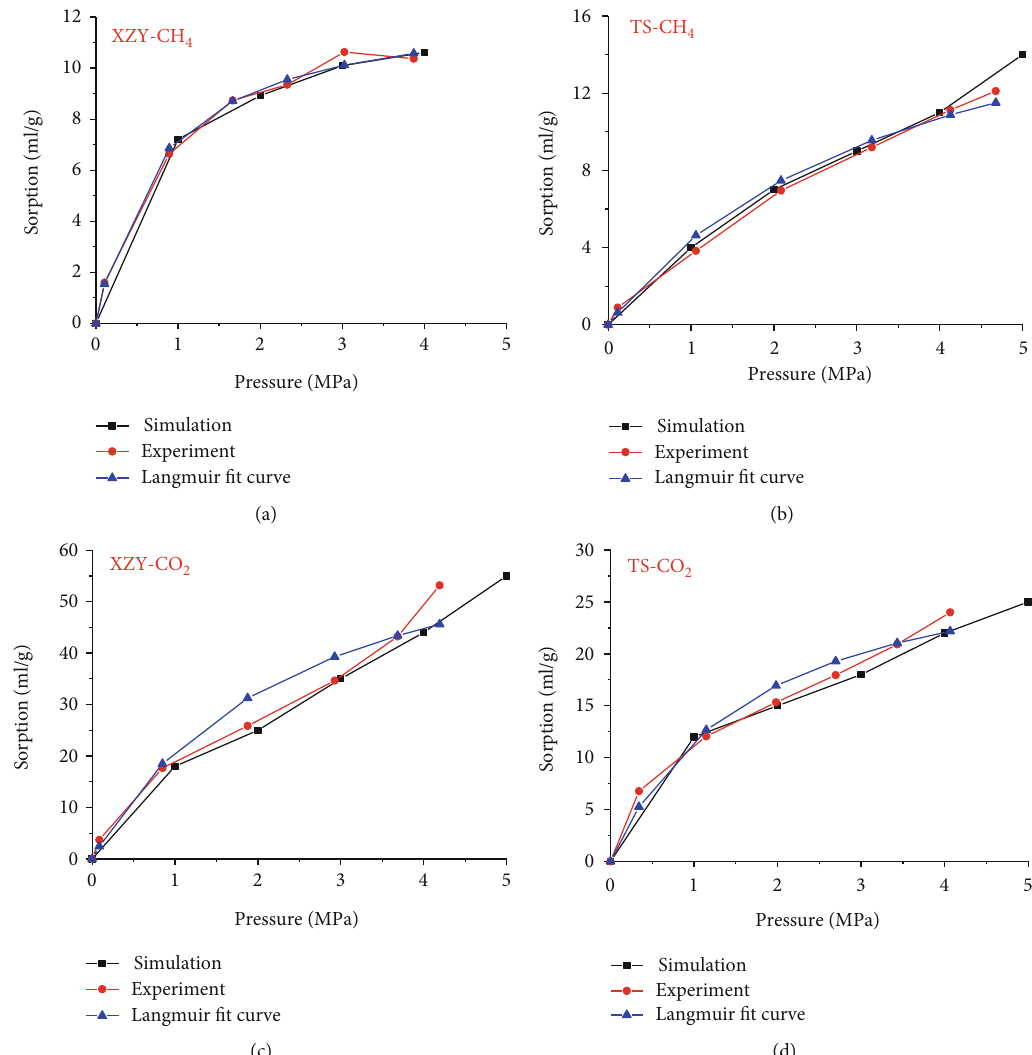
Figure 9: The comparison between simulation and experiment